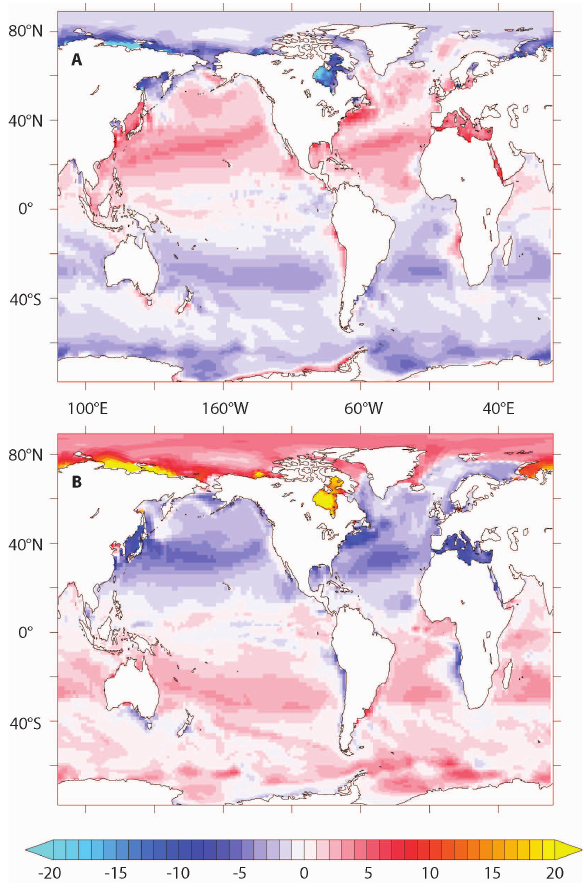
Fig. 4. (A) Difference (µatm) in 2000 between the mean anthro- pogenic 1p CO 2 and the 1p CO 2 computed from the boreal winter (February) trends only. (B) same as A but using the 1p CO 2 com- puted from the boreal summer (August) trends instead of the winter trends.